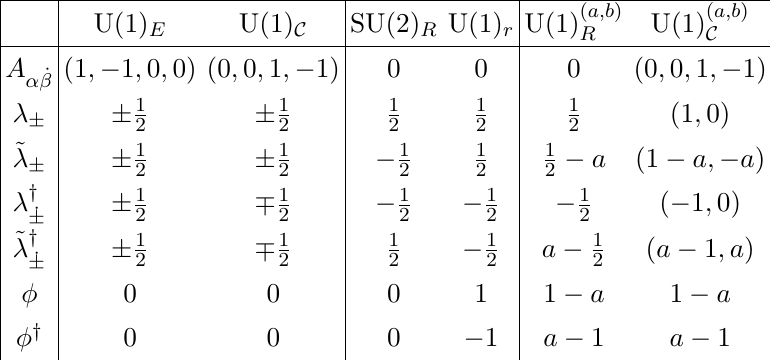
Table 4. Twisting vector multiplets with both SU(2) R and U(1) r .